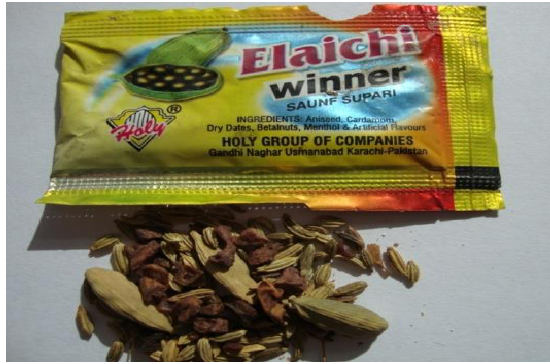
Figure 10. A type of supari that contains cardamom and fennel